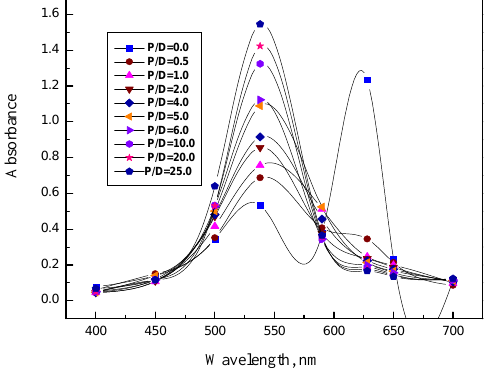
Figure 3. Absorption spectrum of AO-NaCar system at various P/D ratios